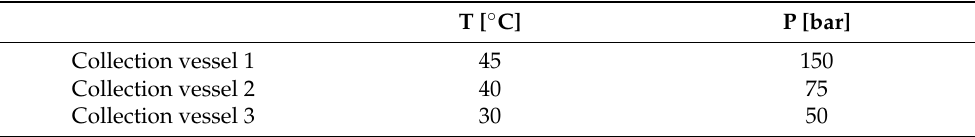
Table 6. Separation conditions used in